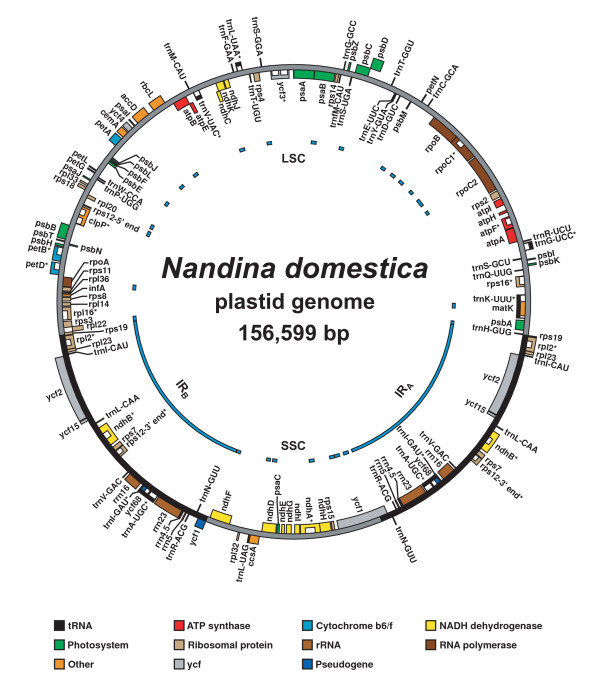
Plastid genome map of Nandina domestica (Berberidaceae). Map of the plastid genome of Nandina domestica (Berberidaceae), showing annotated genes and introns. Asterisks (*) after the gene names indicate the presence of introns; the introns themselves are denoted by white boxes within genes. Within the genome map, the inverted repeat regions (IRA and IRB) are depicted by the solid black bars, and the large and small single-copy regions (LSC and SSC) are depicted by the solid gray bars. Regions that were conventionally sequenced are indicated by the blue bars to the inside of the genome map.